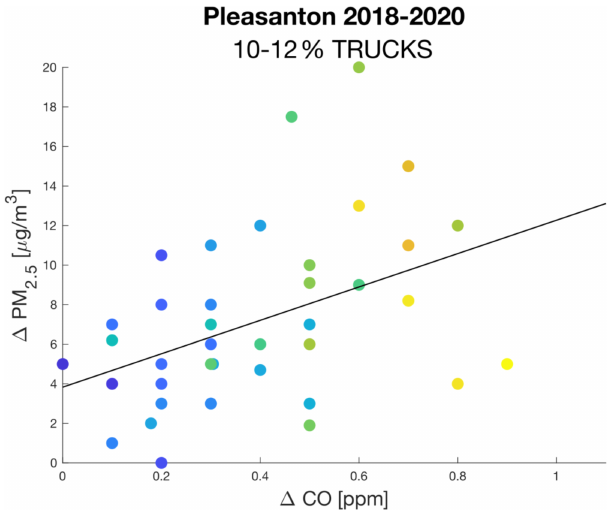
Figure 3. (cid:49) PM vs. (cid:49) CO at the Pleasanton site during the 2018– 2020 time period, for which 10%–12% of traffic flow are trucks. Data are colored by NO x concentration. These points are fit linearly to find the